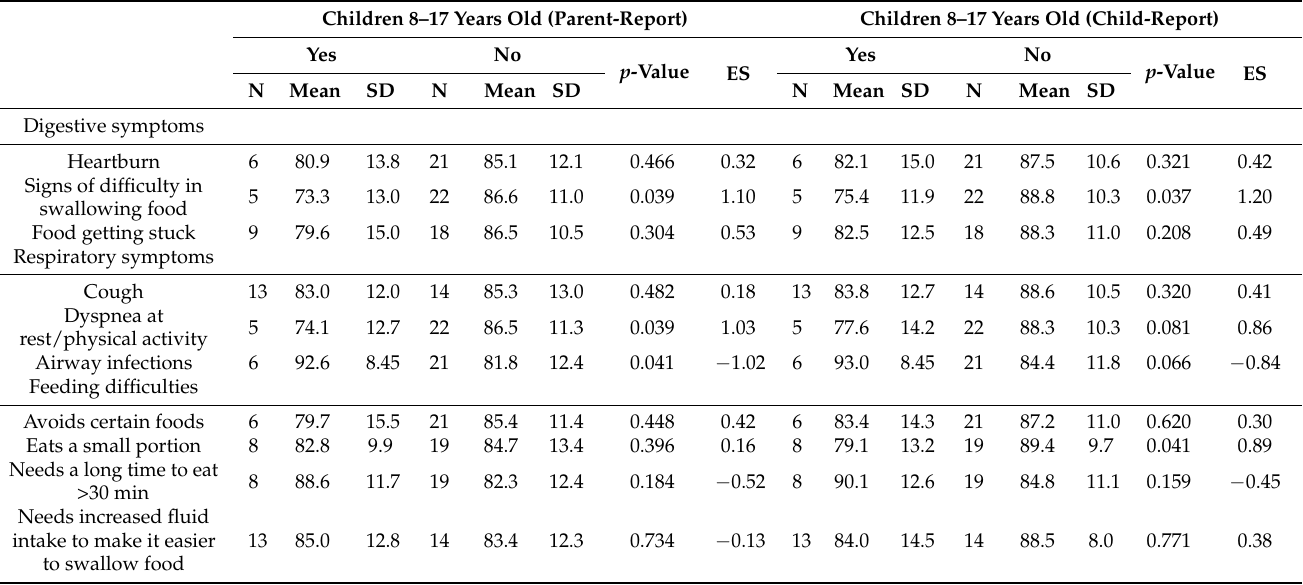
Table 6. Comparison of the total scores on the EA-QOL questionnaire between clinical subgroups in children aged 8–17. p < 0.05 values are